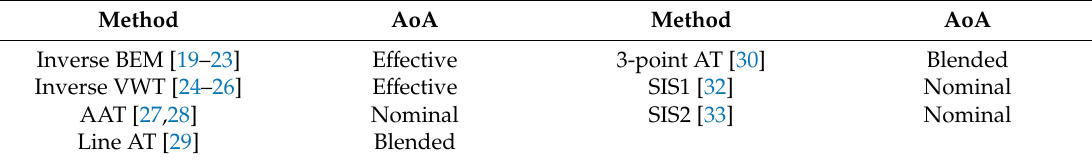
Figure 1. Different kinds of inductions in the flattened section of a certain radial location: ( a ) Bent streamlines because of disc-induction; ( b ) self-induction; ( c ) downwash because of 3D-induction. Table 1. List of the angle of attack (AoA) determination methods and their corresponding kinds of AoA.